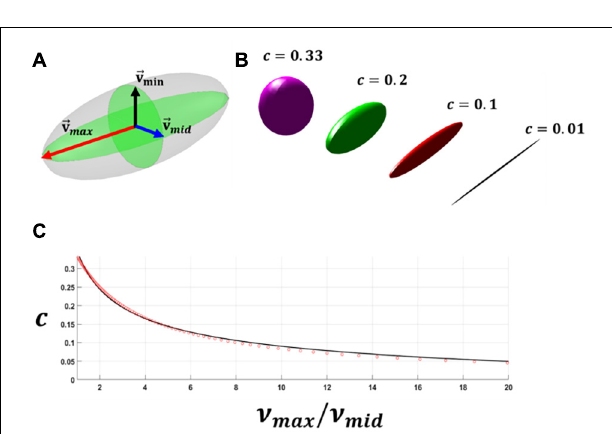
FIGURE 5 | (A) A schematic representation of each family of the collagen fibres in an ellipsoid form using the eigenvalues and eigenvectors of the generalised structure tensor h. (B) A schematic representation showing the dispersion of the fibres and eccentricity of the ellipsoid. (C) The figure relating the ratio of the maximum and intermediate eigenvalues of the generalised structure tensor to dispersion of the fibres.